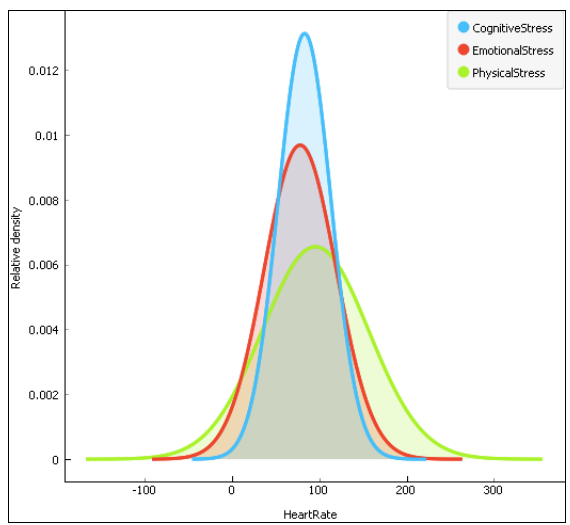
Figure 6. The distribution of the heartrate data according to the three stress types.